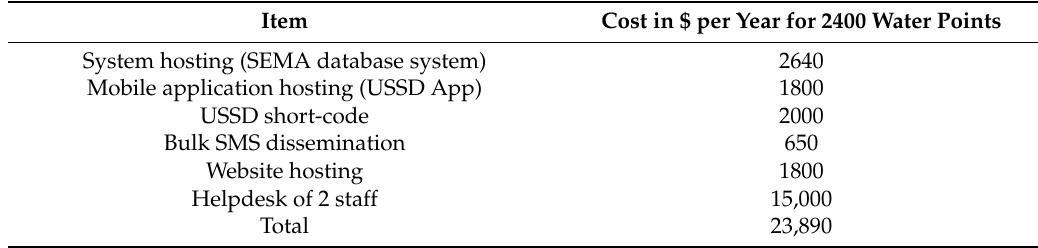
Table 5. Annual cost of SEMA in four districts. The total cost per water point per year is US$9.95 (at the time of writing 22,049 Tanzanian